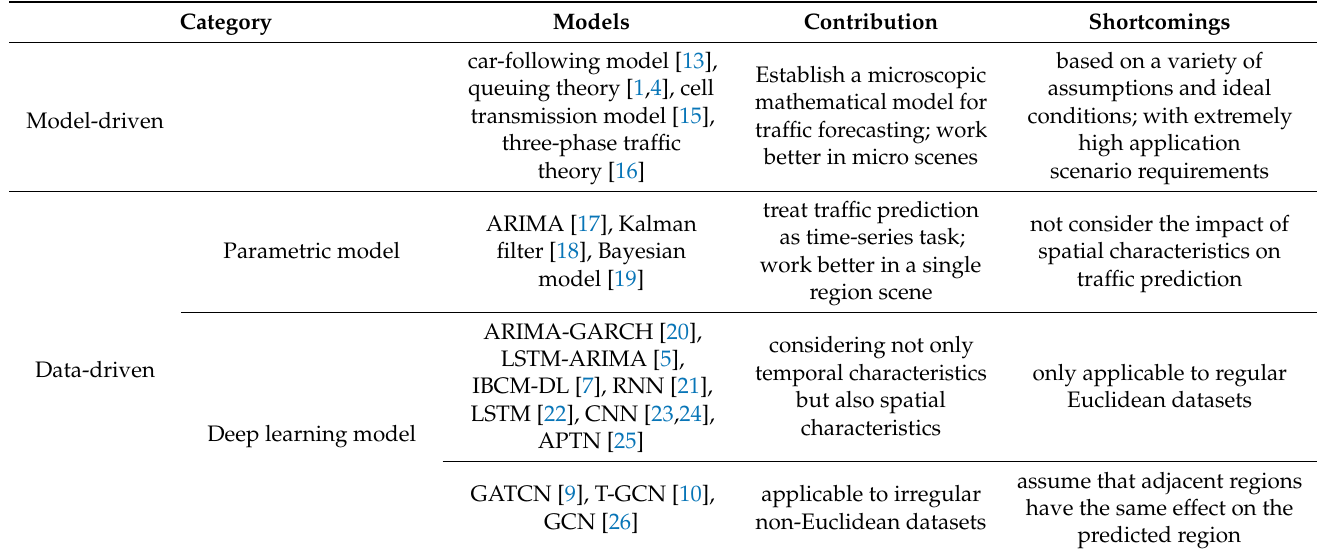
Table 1. Existing research on traffic